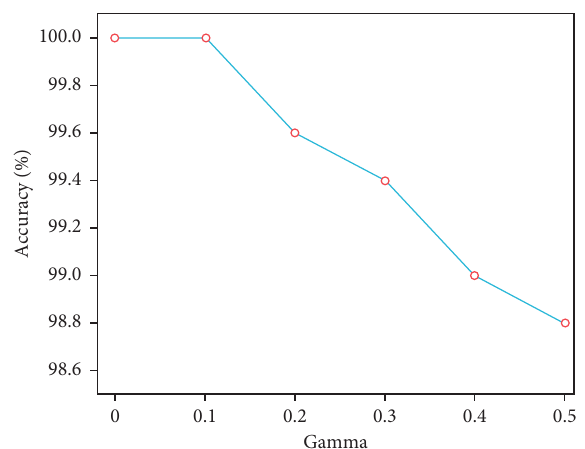
Figure 17: The influence of c on the diagnosis accuracy of the model.